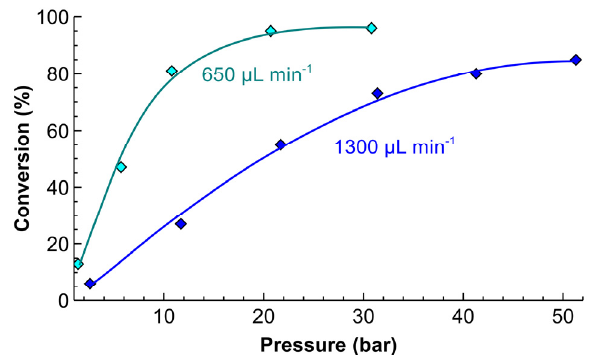
Figure 7. MBY conversion as a function of reaction pressure in the hydrogenation of a 30 vol% MBY aqueous solution in a 5 m reactor coated with a 5 wt% Pd/ZnO catalyst. Reaction conditions: liquid flow rate 0.65 or 1.3 mL min − 1 , H 2 flow 55 or 110 mL min − 1 (standard temperature and pressure, STP), respectively. The reaction temperature: 50 °C. The MBE selectivity was 99.0% in the entire range of conditions studied.